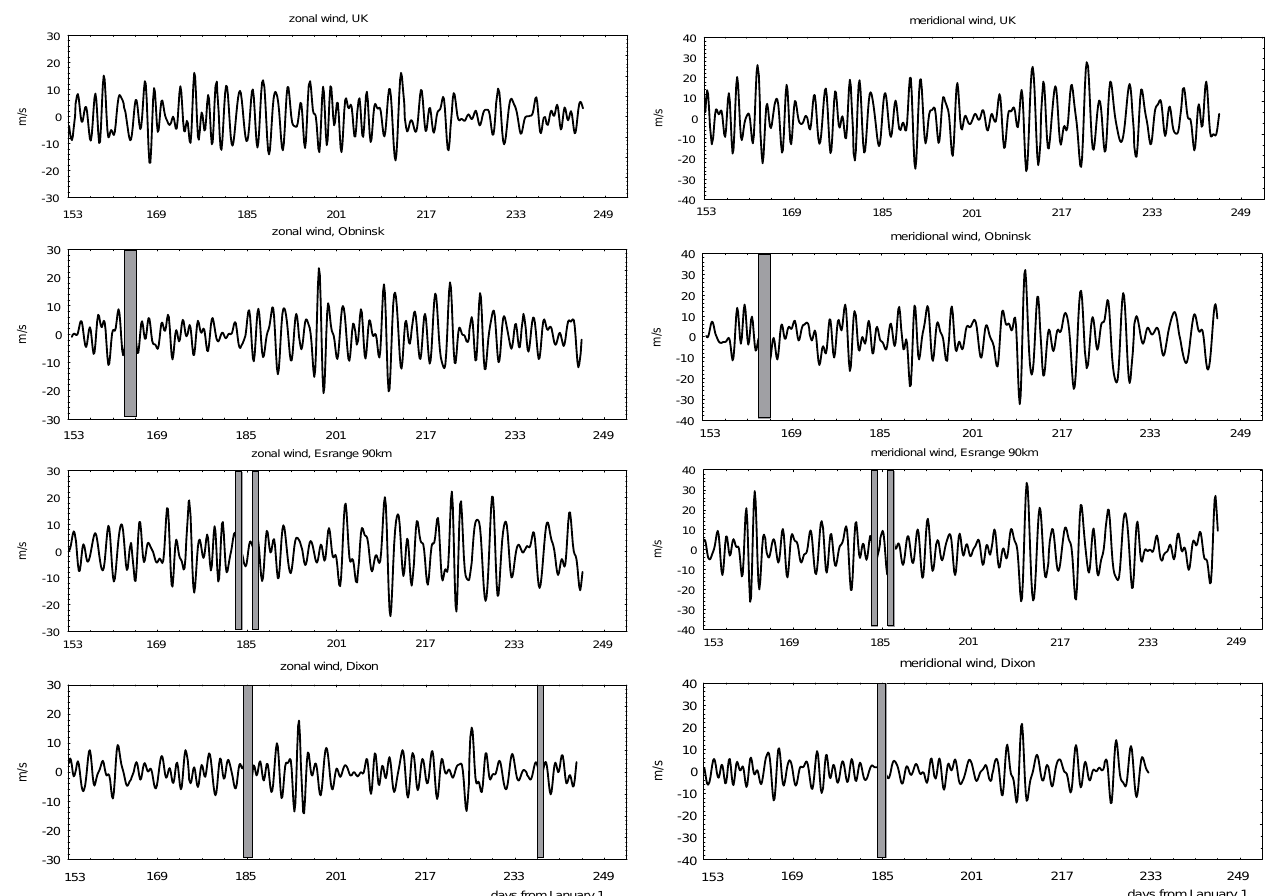
Fig. 1. (left) Zonal and (right) meridional components of the winds observed from day 153 (1 June) to day 244 (31 August) in 2000. Data have been band-pass filtered to retain periods between 28 and 100h. The longest gaps are